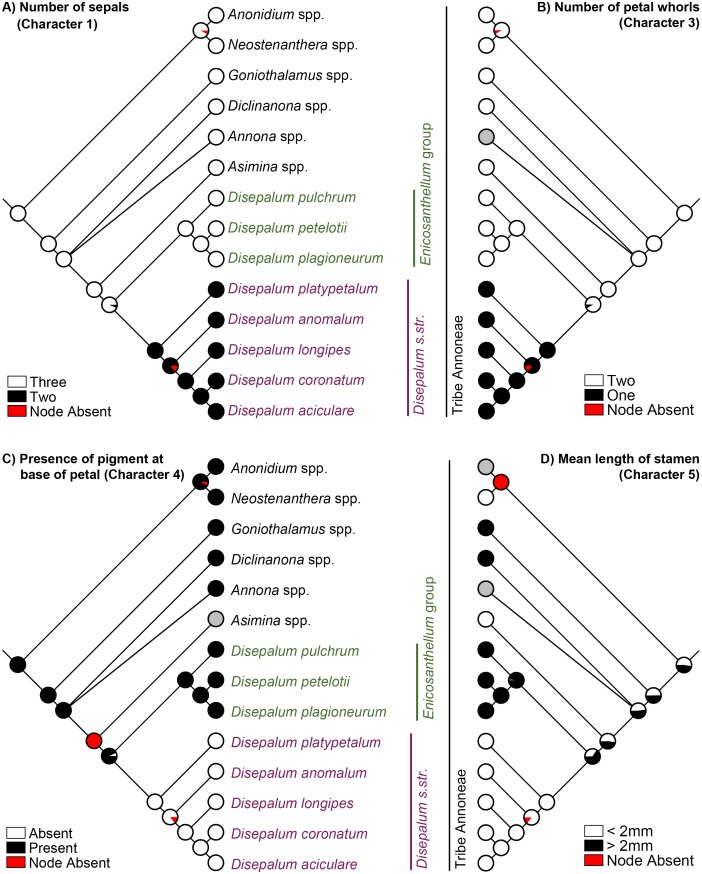
Likelihood ancestral character state estimation for Disepalum and the tribe Annoneae across 90,000 Bayesian input trees, mapped on the Bayesian majority-rule consensus tree under a partitioned model based on combined cpDNA (matK, trnL-F, ndhF and ycf1) and nDNA (AP3 and phyA) sequence data.(A) Number of sepals (character 1). (B) Number of petal whorls (character 3). (C) Presence of pigment at base of petals (character 4). (D) Mean length of stamens (character 5). Pie charts at each node show the percentage of node absence in the input trees and the average likelihood received by each state across all input trees possessing that node. Grey circles indicate unknown character states.